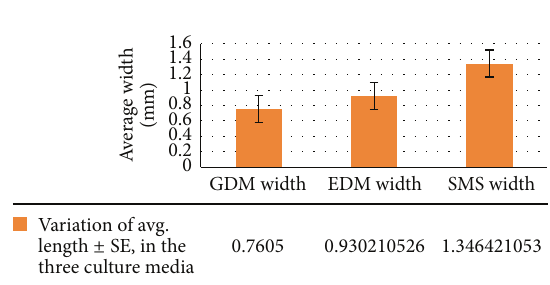
Figure 2: Variation of avg. width ± SE, in the three culture